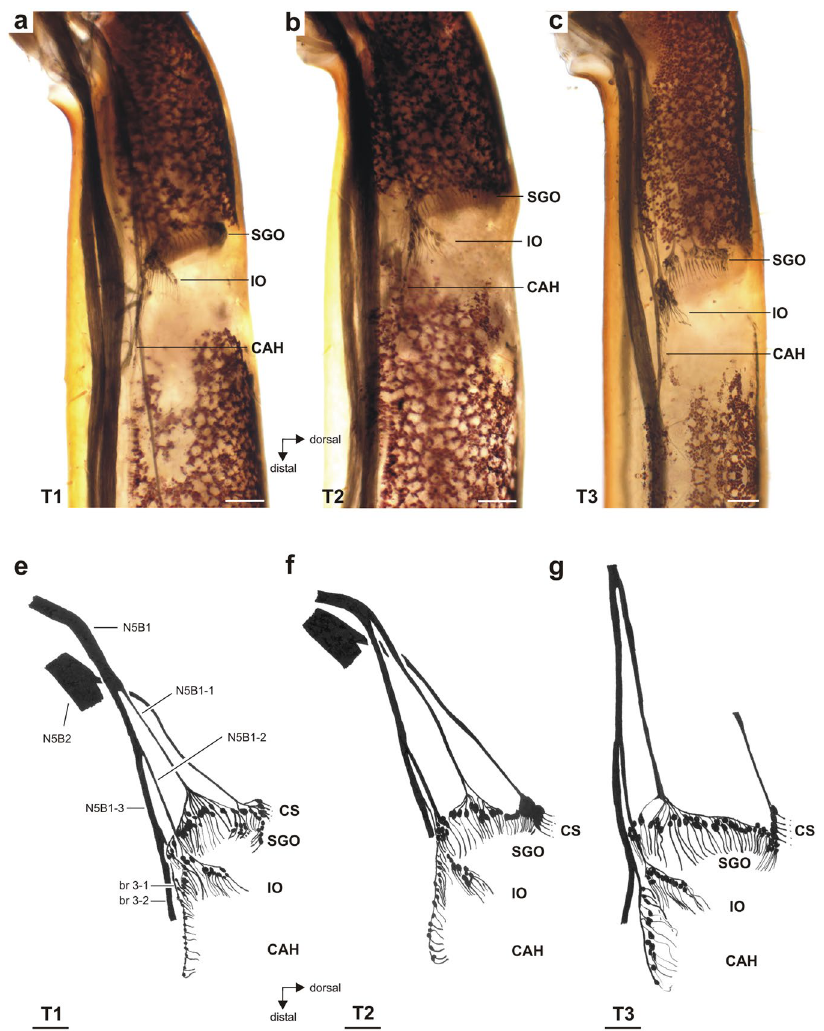
Figure 4. Whole mount preparations and schematic of the complex tibial organ in all three leg pairs. ( a – c ) In all legs, the subgenual organ (SGO), intermediate organ (IO) and crista acustica homolog (CAH) are present. Viewed from anterior. Note the lack of pigmentation in the cuticle at the level of the sensory organs. ( d – f ) Drawings of the complex tibial organ and its innervation in serial organisation. Anterior perspective. The structure and innervation of sensory organs were highly similar in all three leg pairs. Innervating nerves and nerve branches are labelled for the foreleg. The accessory organ, which is also innervated by N5B2, has been omitted for clarity. For the hindleg T3, the nerve N5B2 is omitted. Abbreviations: CAH , crista acustica homolog; CS, campaniform sensilla; IO, intermediate organ; SGO, subgenual organ; T1, foreleg; T2, midleg, T3, hindleg. Scale = 100 µ